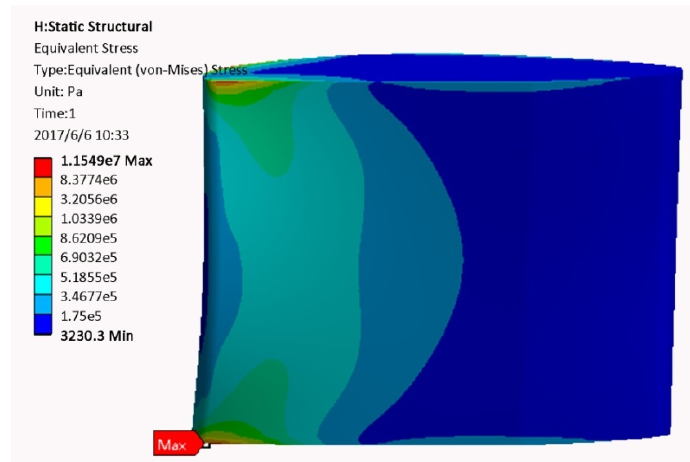
Figure 12. Von Mises stress distribution of the stay vane.